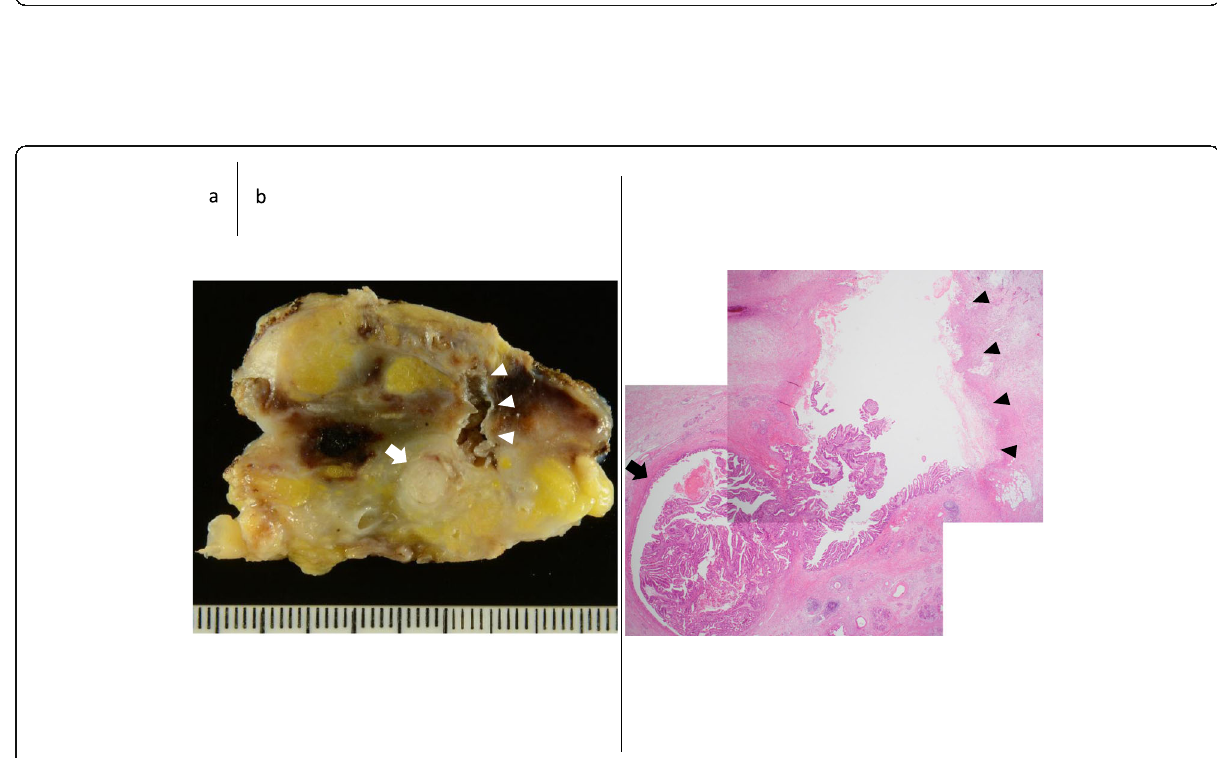
Fig. 3 Macroscopic findings. a Enlarged view of a section of the resected specimen after formalin fixation containing the main tumor. b A loupe view of the same section. A tubulopapillary tumor measuring 37 × 25 mm was found within the main pancreatic duct (arrow), and a fistula connecting the main pancreatic duct to the extrapancreatic scar tissue had formed